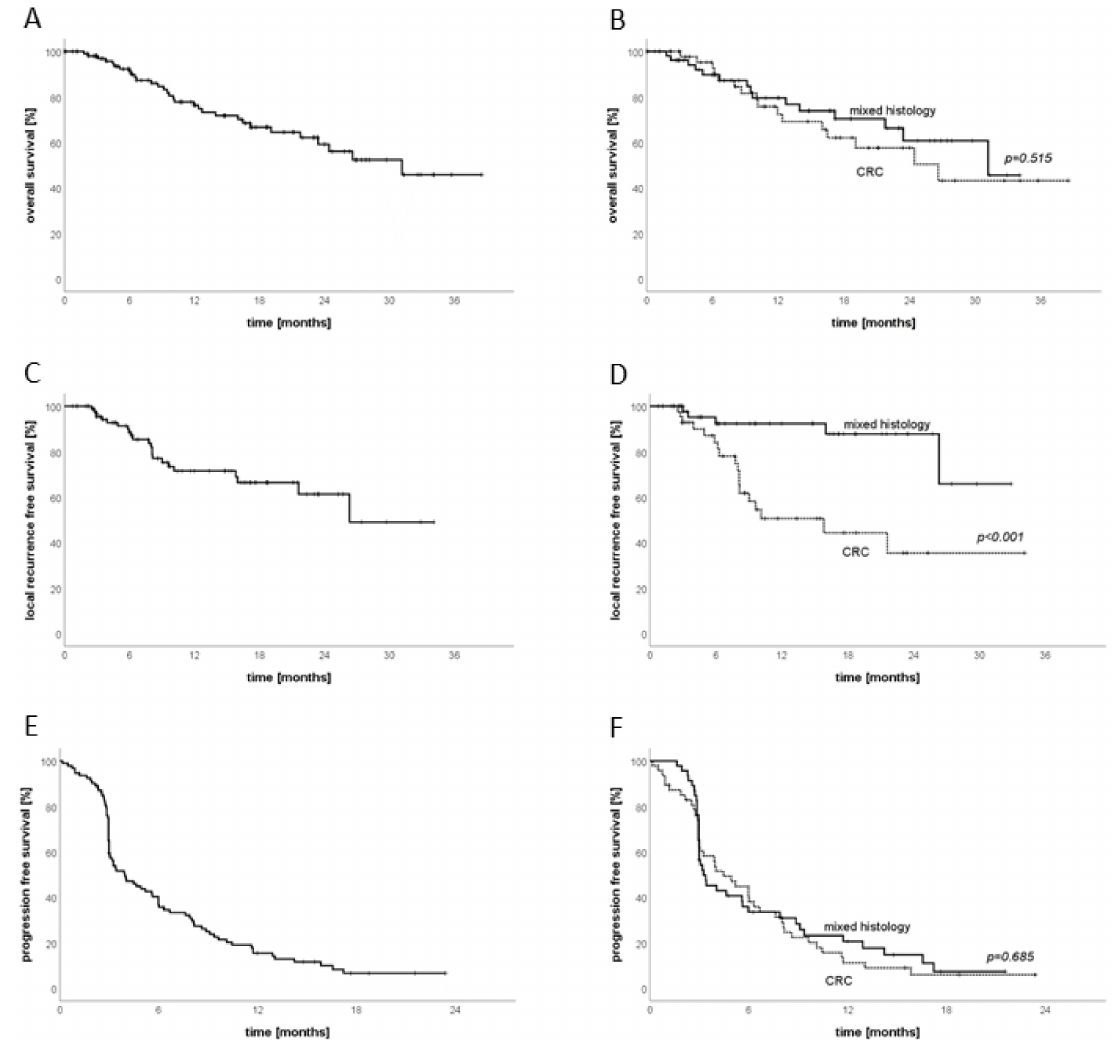
Figure 2. Oncologic outcome of interstitial brachytherapy. ( A ) Overall survival; ( B ) overall survival CRC vs. mixed histology; ( C ) local-recurrence-free survival; ( D ) local-recurrence-free survival CRC vs. mixed histology; ( E ) progression-free survival; ( F ) progression-free survival CRC vs. mixed histology.